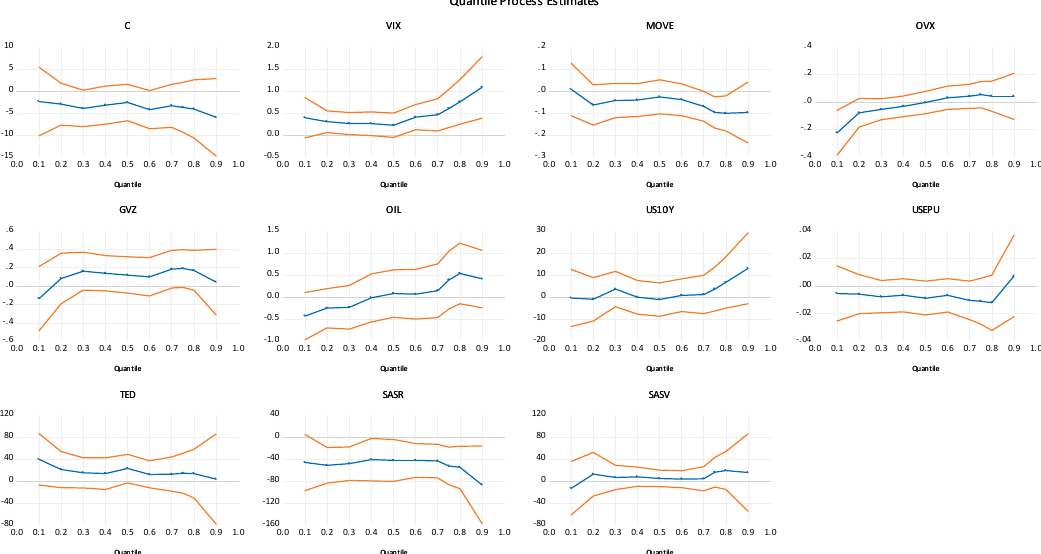
Figure 6. Quantile regression coefficient estimates in the case of Saudi Arabia, with 95% confidence intervals. Vertical axes show the coefficient estimates of the explanatory variable over the Saudi Arabia CDS spreads distribution. Horizontal axes show the quantiles of the dependent variable.